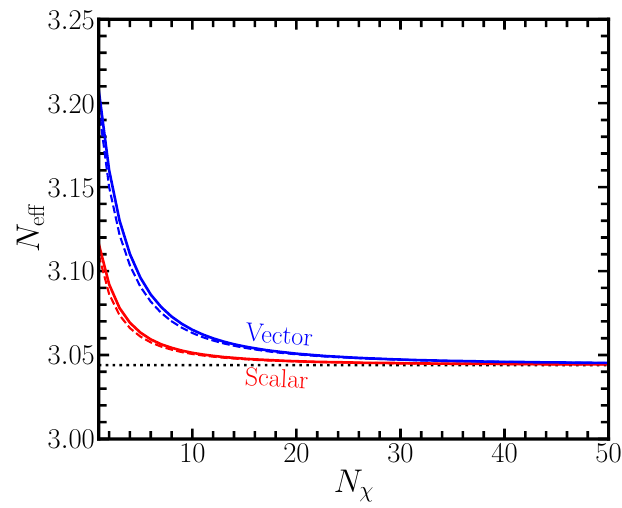
Figure 5 . N eff as relevant for CMB observations as a function of the number of massless species that eventually thermalise with neutrinos N . In blue when the mediator is a vector boson with χ g X = 3 and in red when we have a scalar mediator with g X = 1 . Dashed lines correspond to the case of χ being bosons and solid lines to the case of χ being bosons. The black dotted line shows the SM prediction of N = 3 . 044 eff